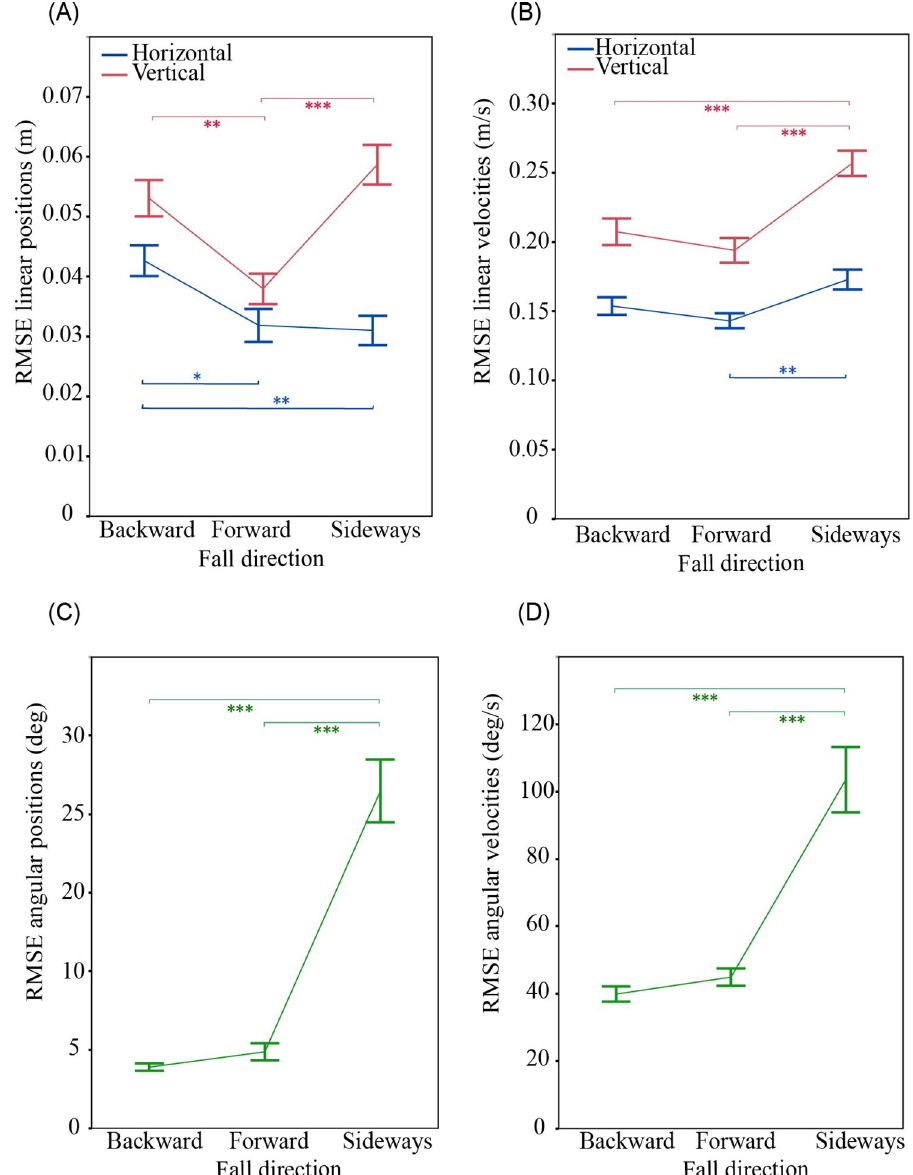
Fig 5. Effect of fall direction on accuracy of Kinovea estimates. (A) Linear position, (B) linear velocity, (C) angular position, and (D) angular velocity. RMSEs are based on comparison of Qualisys ground truth signal to Kinovea data from the 90 deg camera angle, calibrated with the calibration frame located in the plane of the fall, with position data filtered at 10 Hz. Data points show mean values averaged across all body parts with error bars showing ± 1 SE. � p � 0.05, �� p � 0.01, ��� p �